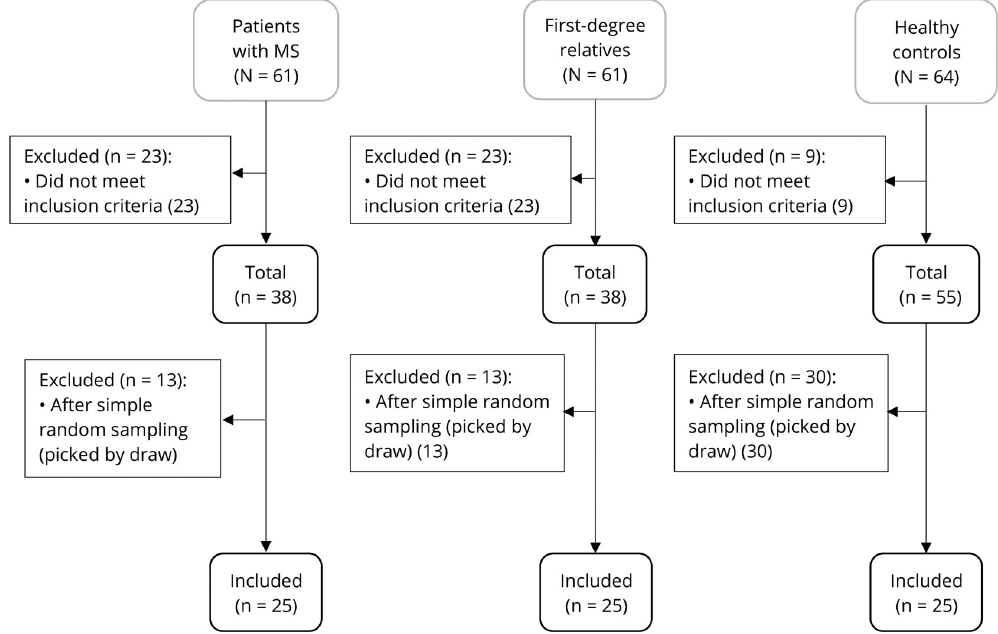
Fig 1. Enrollment and selection of participants allocated to groups by simple random